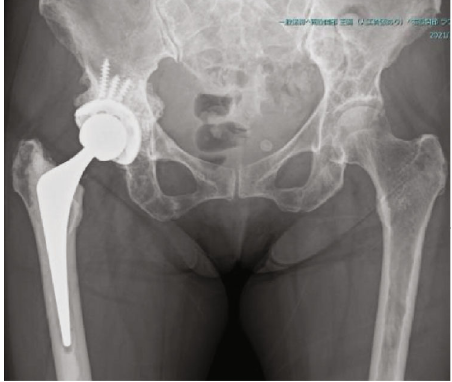
Figure 6: Plain radiograph at 3 years after surgery shows no signs of bone absorption or implant